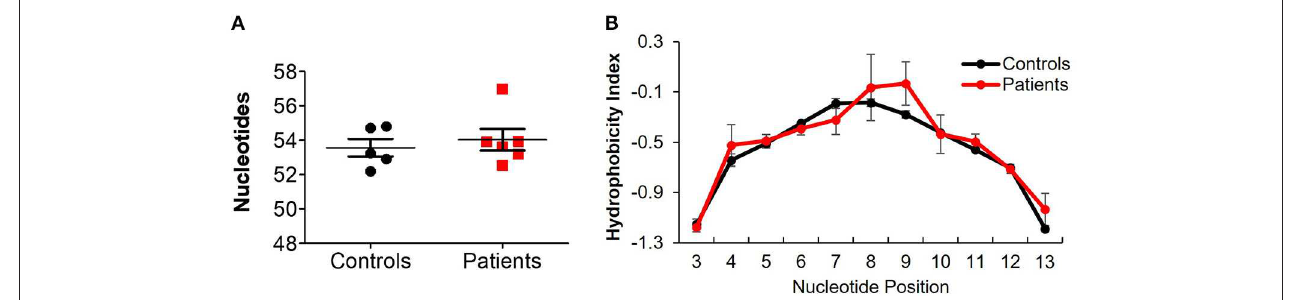
FIGURE 6 | Comparable IgH length and hydrophobicity between controls and IL10/IL10R-deficient patients. (A) CDR3H length in blood of patients and controls. (B) Hydrophobicity index of the CDR3H region. Position signifies successive amino acid location at the CDR3 β region. Bars represent mean ± SEM.